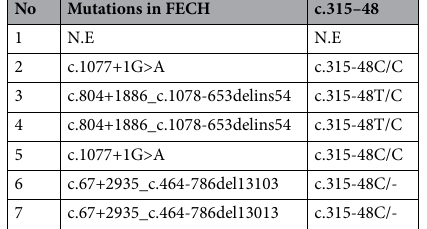
Table 2. Genetic testing for EPP diagnosis. N.E. not